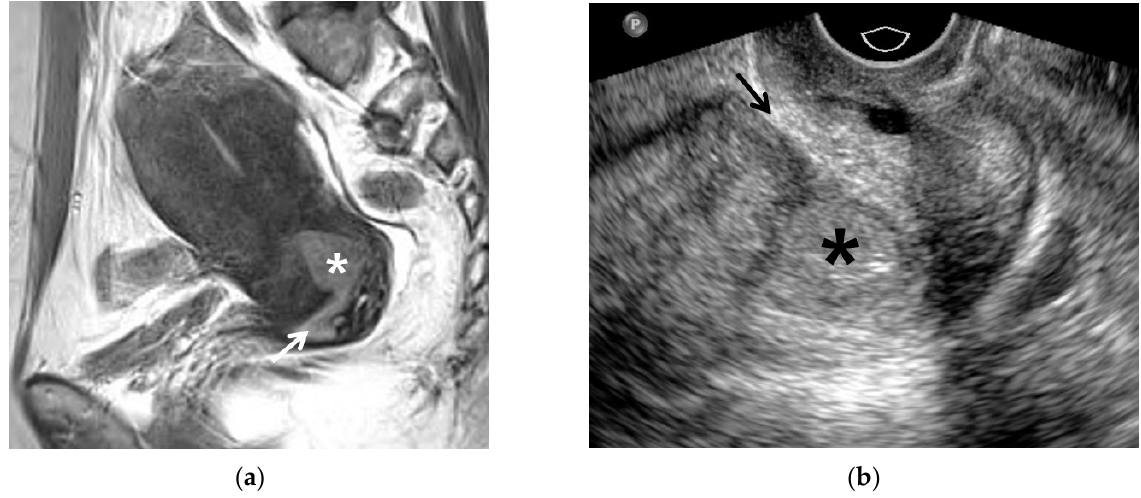
Figure 4. A 53-year-old woman with IB1 endocervical cancer: ( a ) T2-weighted sagittal image clearly depicted an endocervical cancer (asterisk) not detected on visual assessment. The arrow indicates the external meatus of exocervix. This patient had persistent vaginal bleeding prior to admission. ( b ) Longitudinal transvaginal ultrasound image shows a hypoechoic endocervical cancer (asterisk) prior to biopsy. The arrow indicates the external meatus of the exocervix. Histologic diagnosis was